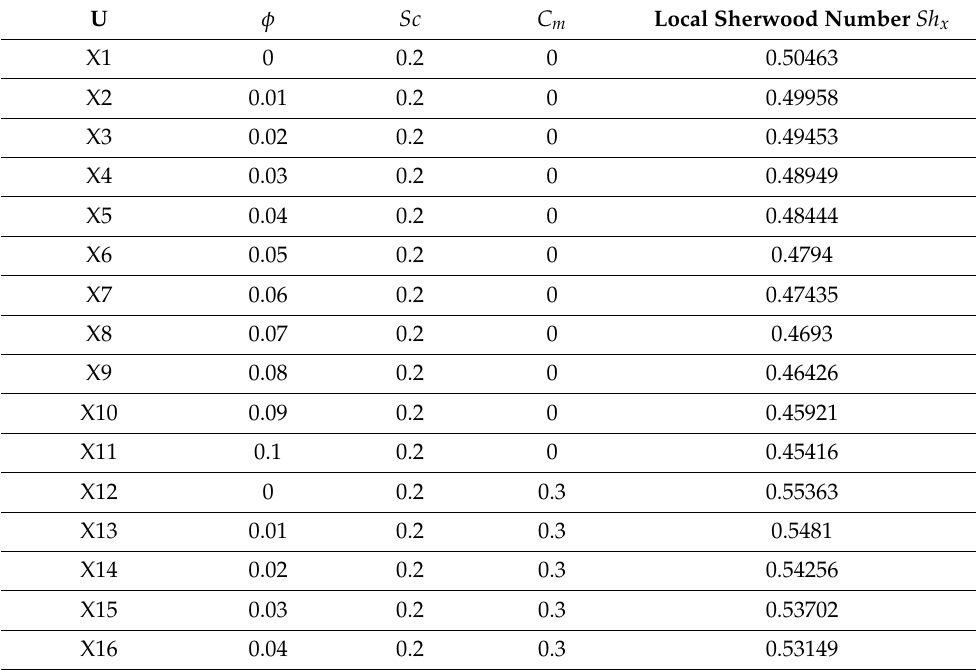
Table 2. Decision Table of Sherwood number for various values of φ , Sc and C m